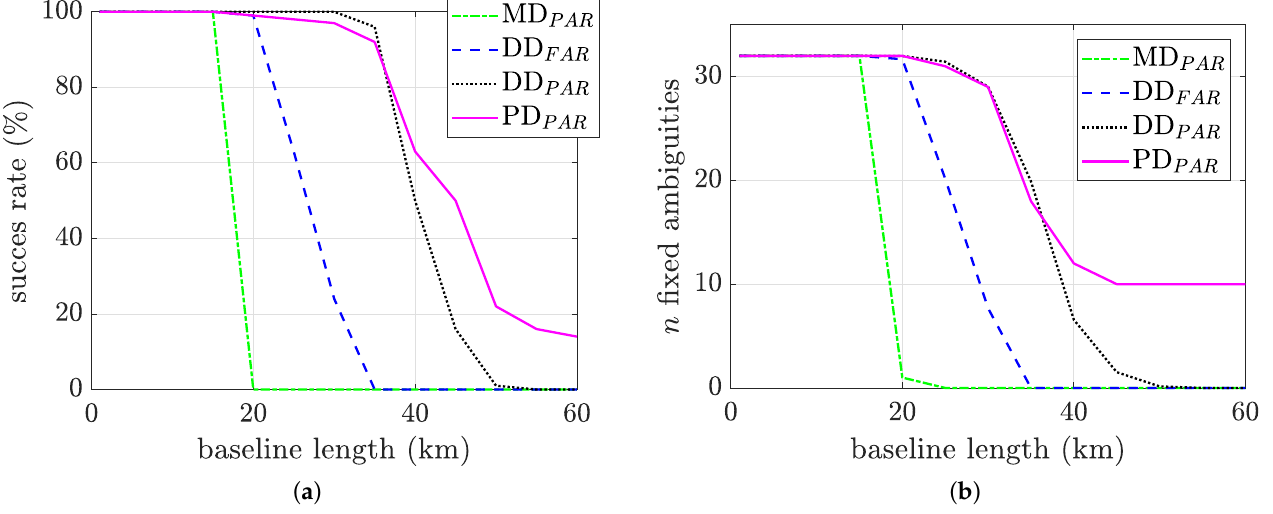
Figure 5. Model-driven (MD), data-driven (DD), and precision-driven (PD) performance analysis. ( a ) Experimental success rate. ( b ) Number of fixed